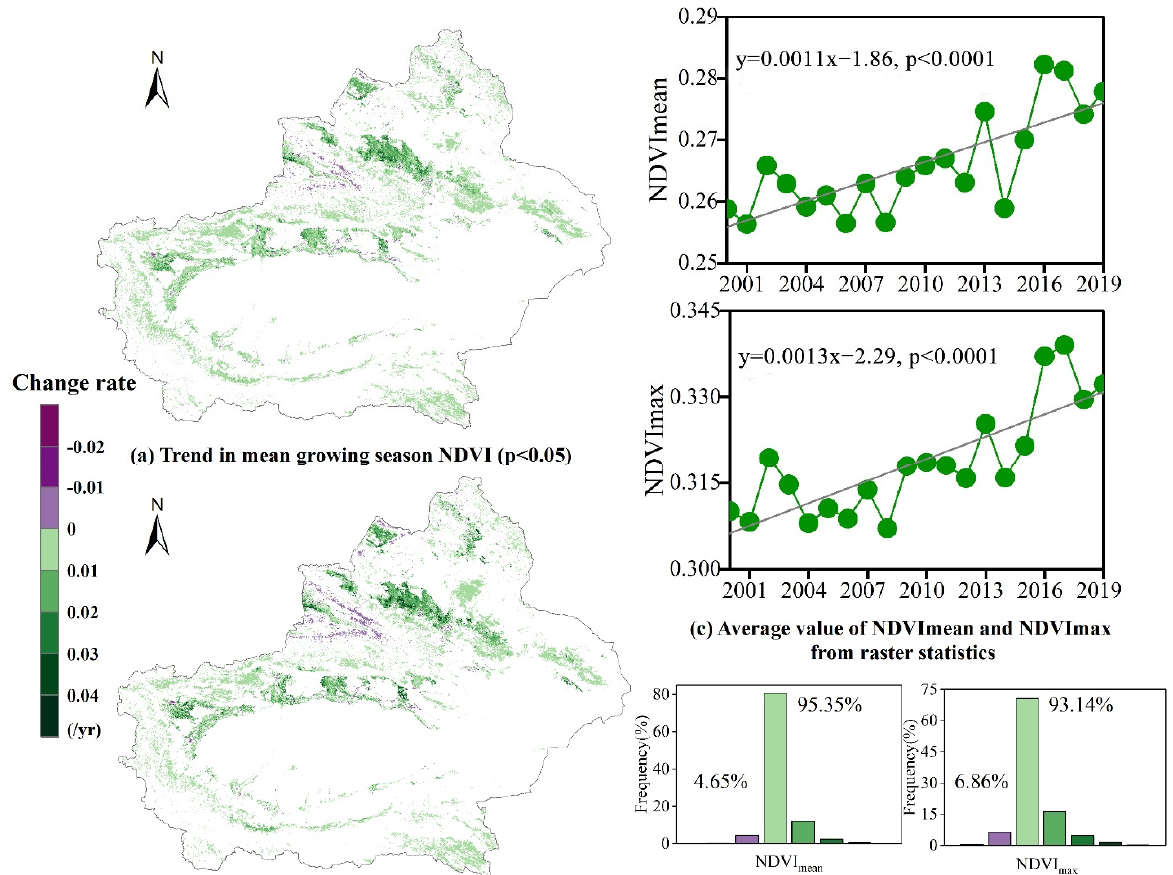
Figure 3. The spatial patterns of ( a ) change rate of mean NDVI (R mean ) for 2000 − 2019 and ( b ) change rate of maximum NDVI (R max ) for 2000 − 2019. The white parts indicate the areas where the multiyear NDVI mean is under 0.1. ( c ) The long-term trend of NDVI mean and NDVI max for 2000 − 2019 based on the average value from zonal raster statistics. ( d ) The frequency of NDVI mean and NDVI max change rate for different numerical intervals. The NDVI was calculated throughout the growing season (May to September).